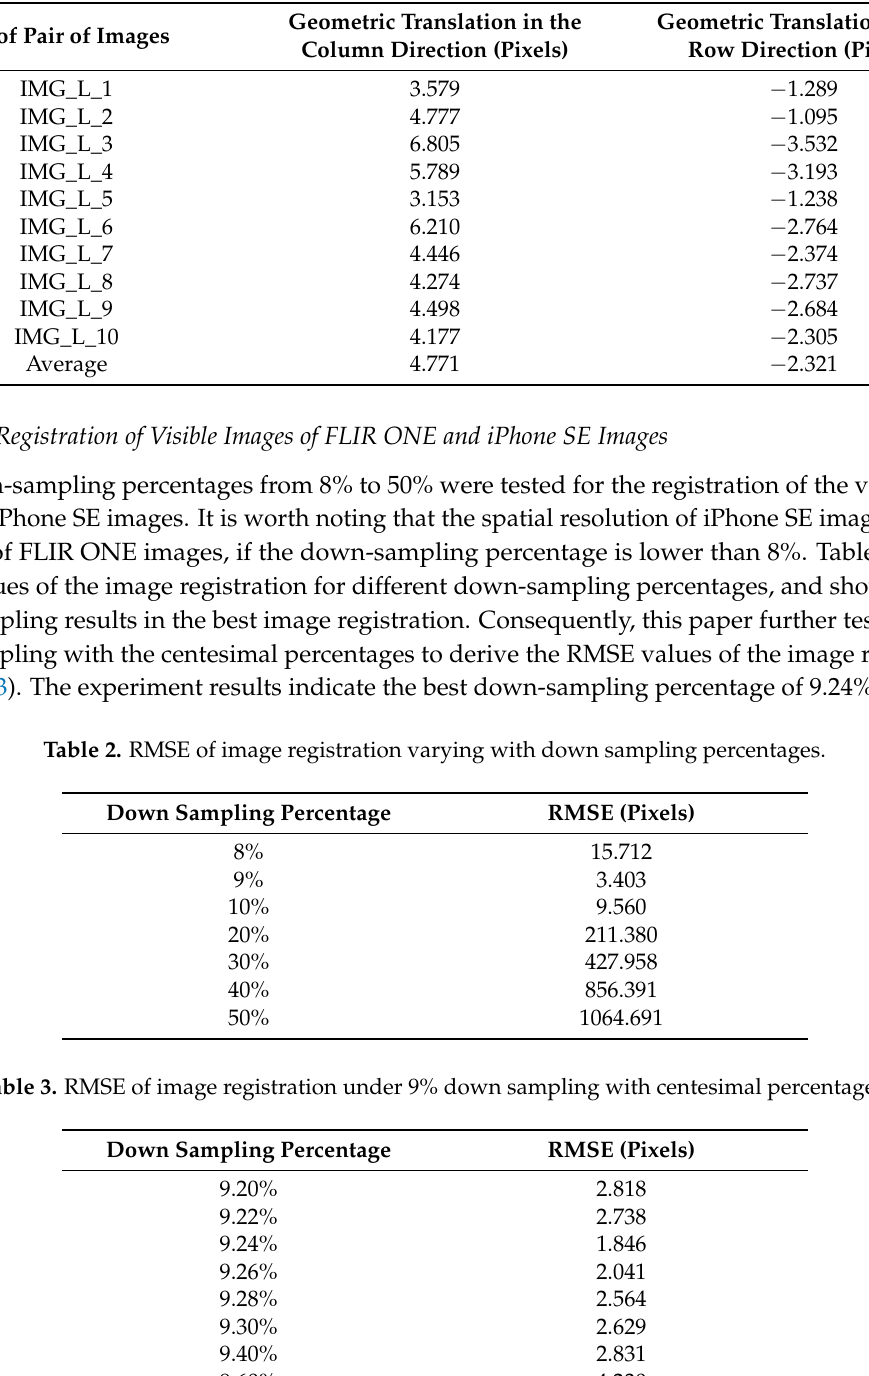
Table 1. Calculation results of the geometric translation.